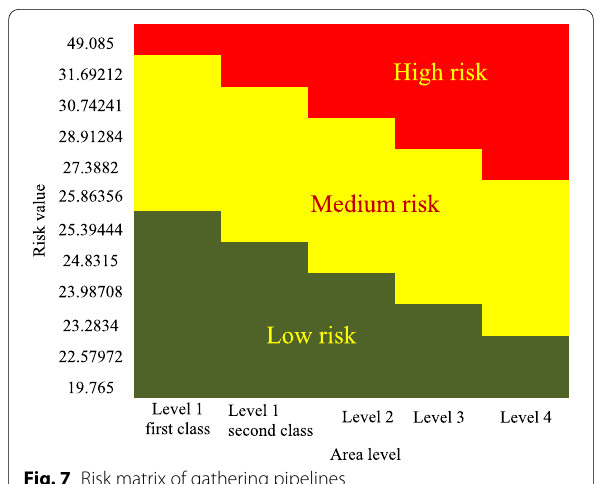
Fig. 7 Risk matrix of gathering